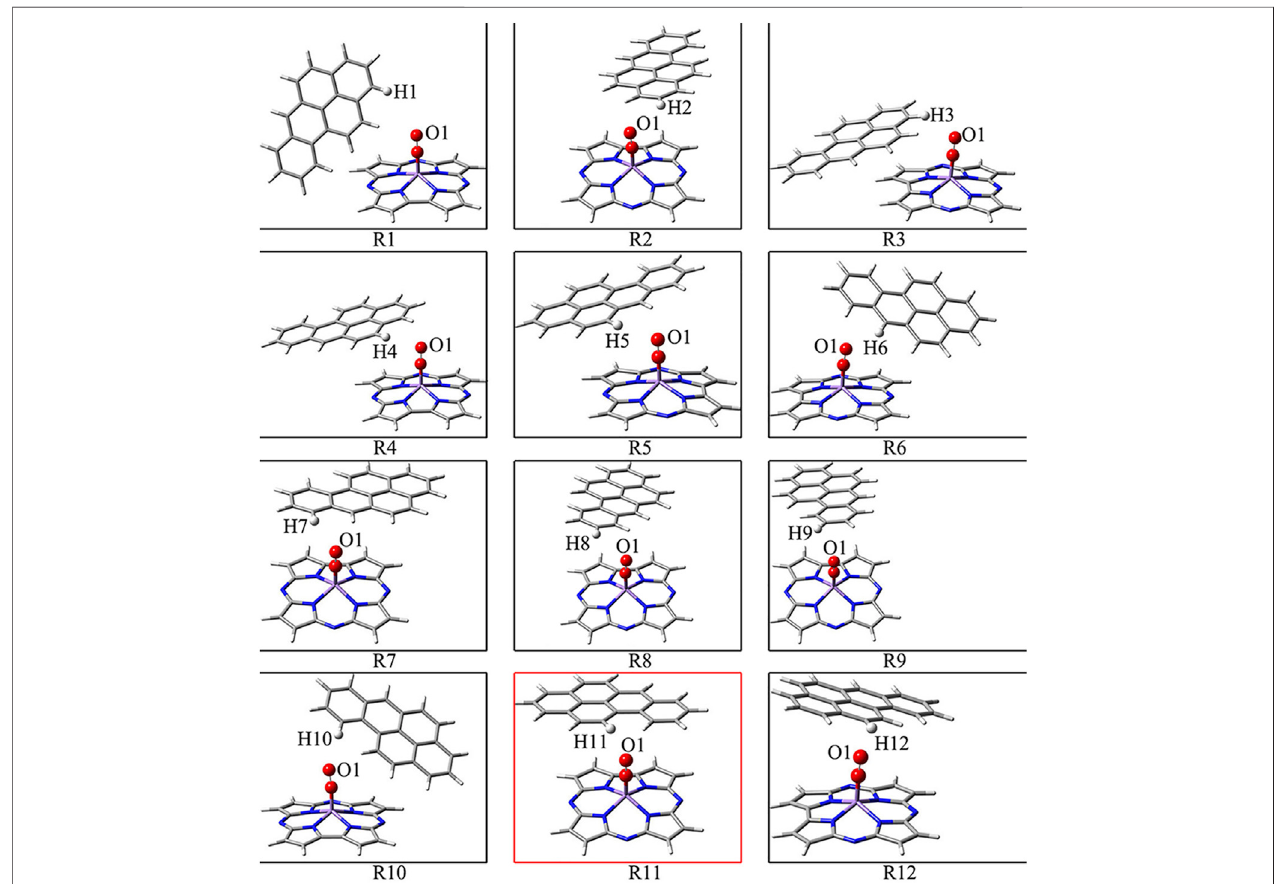
FIGURE 2 | Optimized structures of the different reactant complexes.